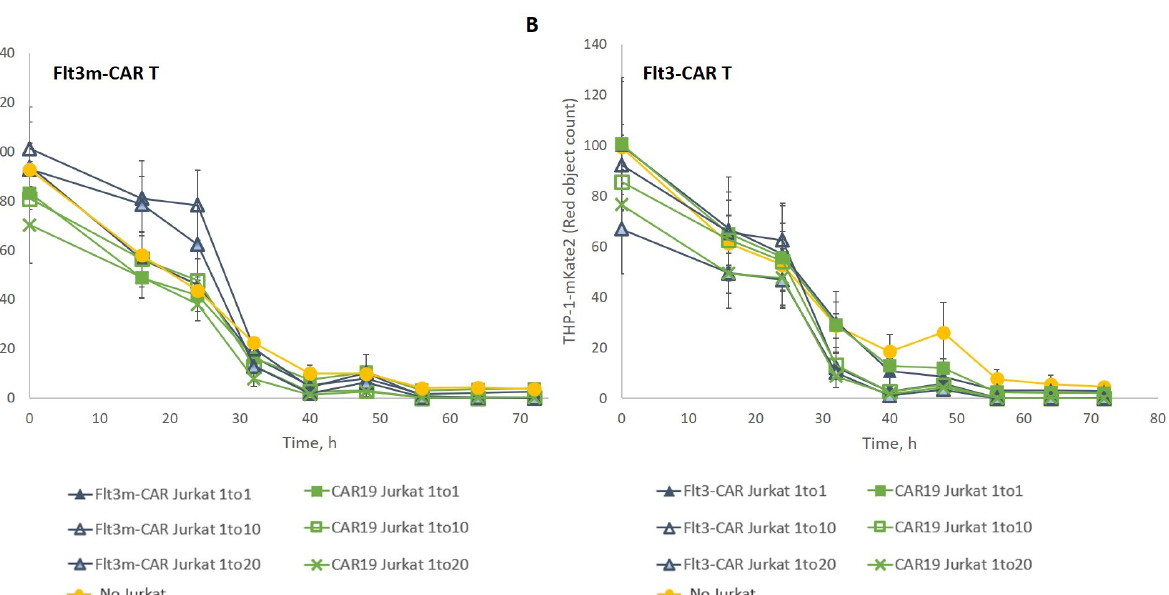
Figure 6. Flt3m-CAR T-mediated killing was not interfered with by recombinant Flt3Lg-L27P. Soluble Flt3Lg-L27P or Flt3Lg (0.2 ng/mL, 2 ng/mL, 20 ng/mL, or 100 ng/mL) was added to co-culture medium prior to the experiment. THP-1-mKate2 cells were incubated with Flt3m-CAR T-cells (light-grey bars) or Flt3-CAR T-cells (black bars). The relative number of alive THP-1-mKate2 cells after 45 h of co-incubation was used to define the % killing shown in the figure (Appendix A for details). Mann–Whitney U-tests were performed to identify significant differences. *** p < 0.001; n.s., not significant.